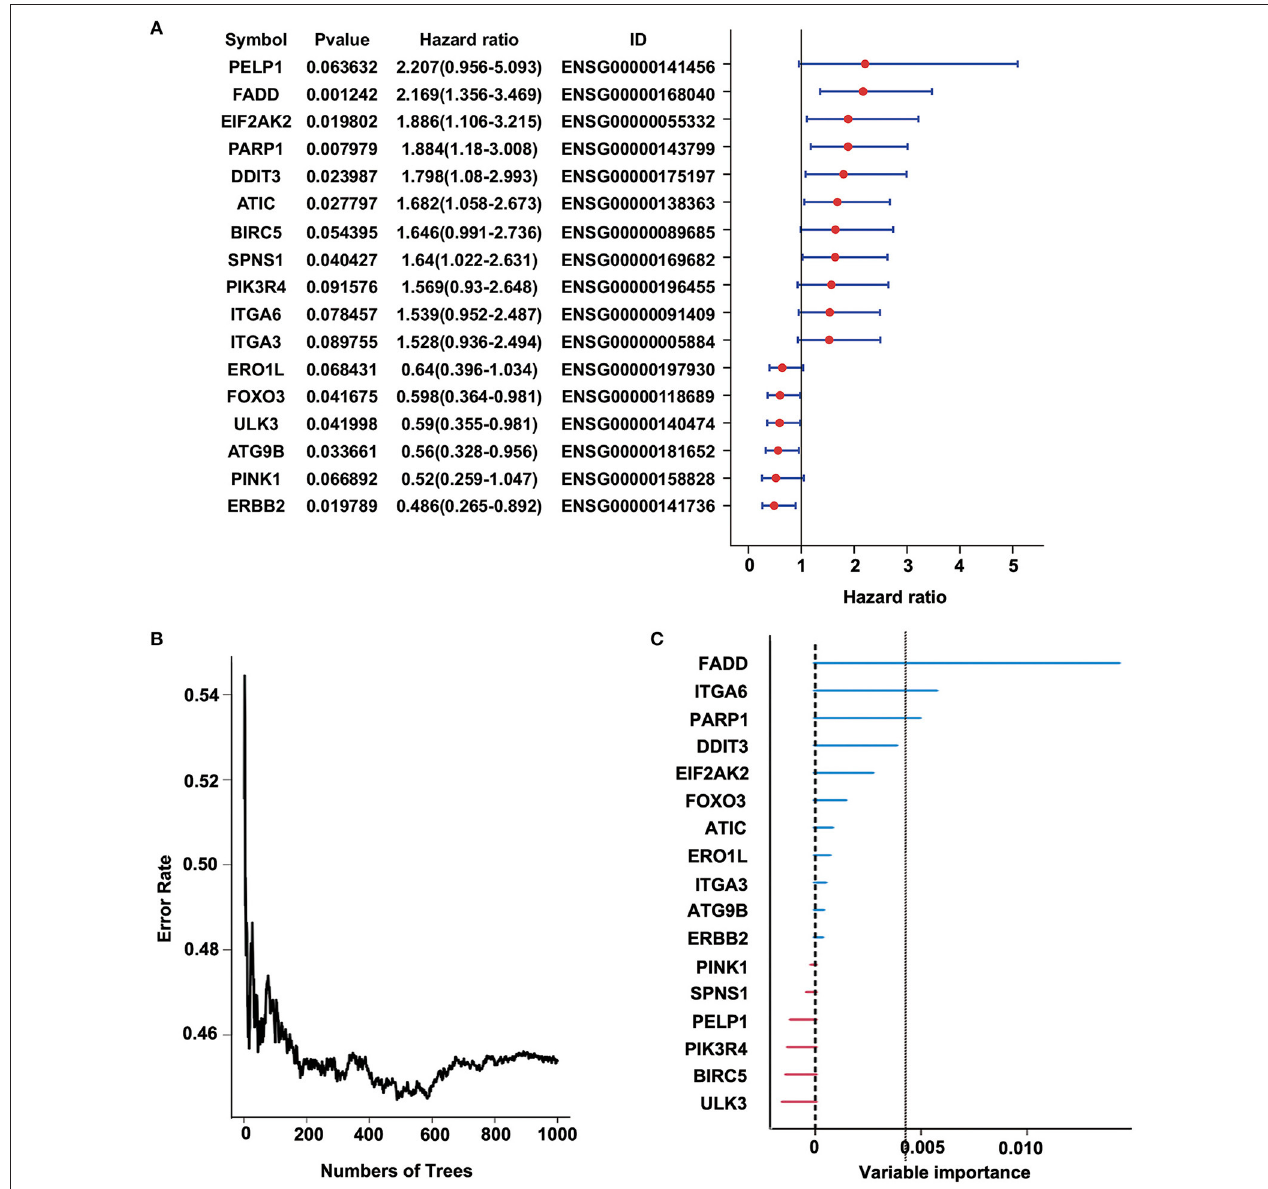
FIGURE 3 | Random forest analysis of prognosis-related autophagy-related genes (ARGs) in the discovery cohort (GSE53624). (A) Forest plot of ARGs with esophageal squamous cell carcinoma (ESCC) survival, univariate Cox regression. (B) Relationship between the error rate and the number of classification trees. (C) Out-of-bag importance values for the predictors.